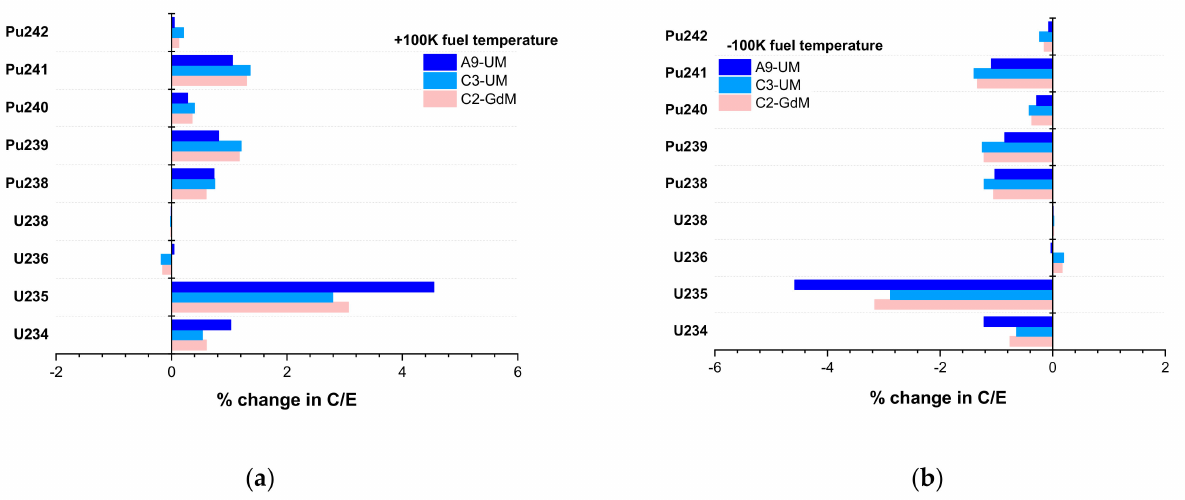
Figure 6. Change in U and Pu isotope C/E ratios due to change in fuel temperature for samples from assembly 2F1ZN3: ( a ) 100 K increase in fuel temperature; ( b ) 100 K reduction in fuel